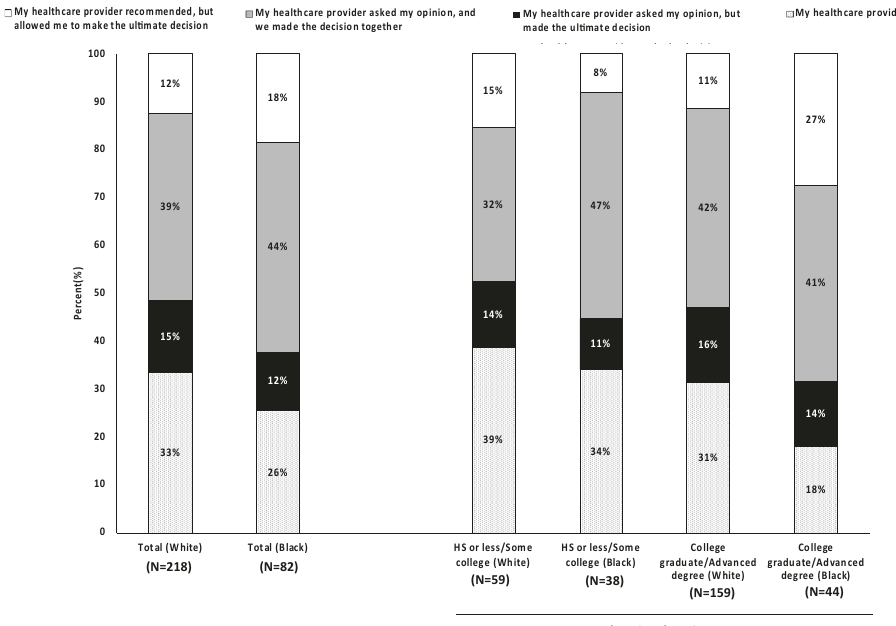
Fig. 2 Patient-reported roles in decision-making for recalled medication changes made during a clinical visit, by self-reported race and educational attainment. N values re fl ect the number of surveys returned from each self-reported racial group regarding clinical visits, not individual/unique patients. Survey responses of patients with “ Unknown ” educational level are not shown. Percent values may not sum to 100% due to rounding effects. Pearson chi-squared tests comparing total sample of self-reported White respondents and total sample of self- reported Black